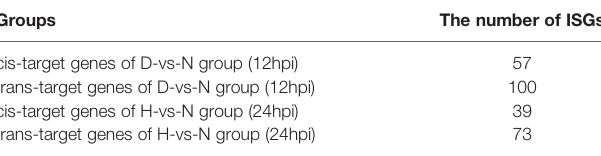
TABLE 4 | The number of ISGs (target genes) of different groups.